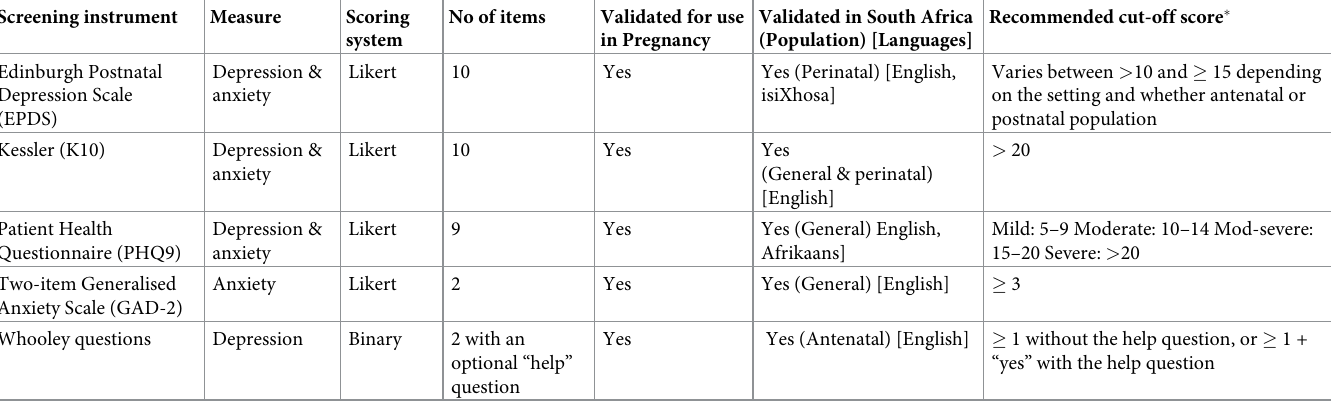
Table 1. Depression and anxiety symptom-screening instruments included in the study. Screening